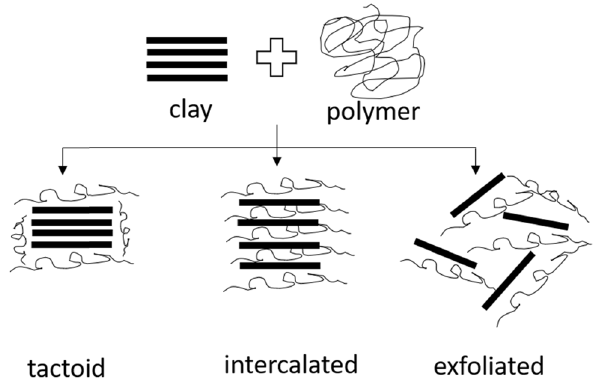
Figure 4: Schematic structure of polymer – clay composites.